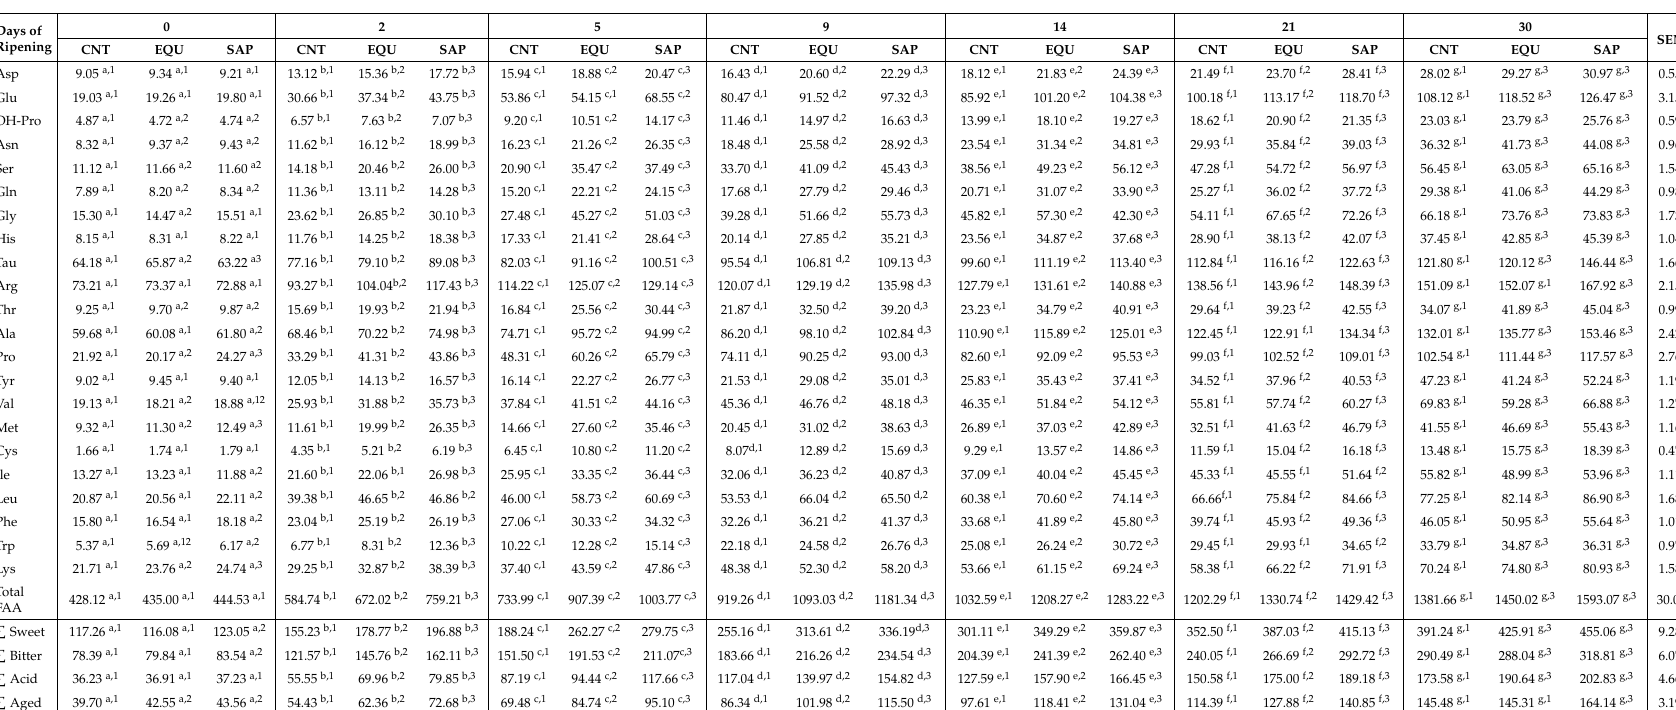
Table 5. Evolution of the free amino acids (mg / 100g of TS) along the manufacturing process of Galician chorizo made without and with starter cultures (means of three replicates in each sausage